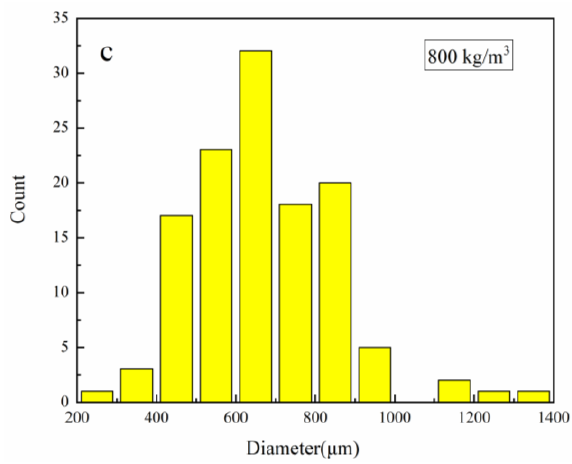
3 , ( b ) 600 kg/m 3 and ( c ) 800 kg/m 3